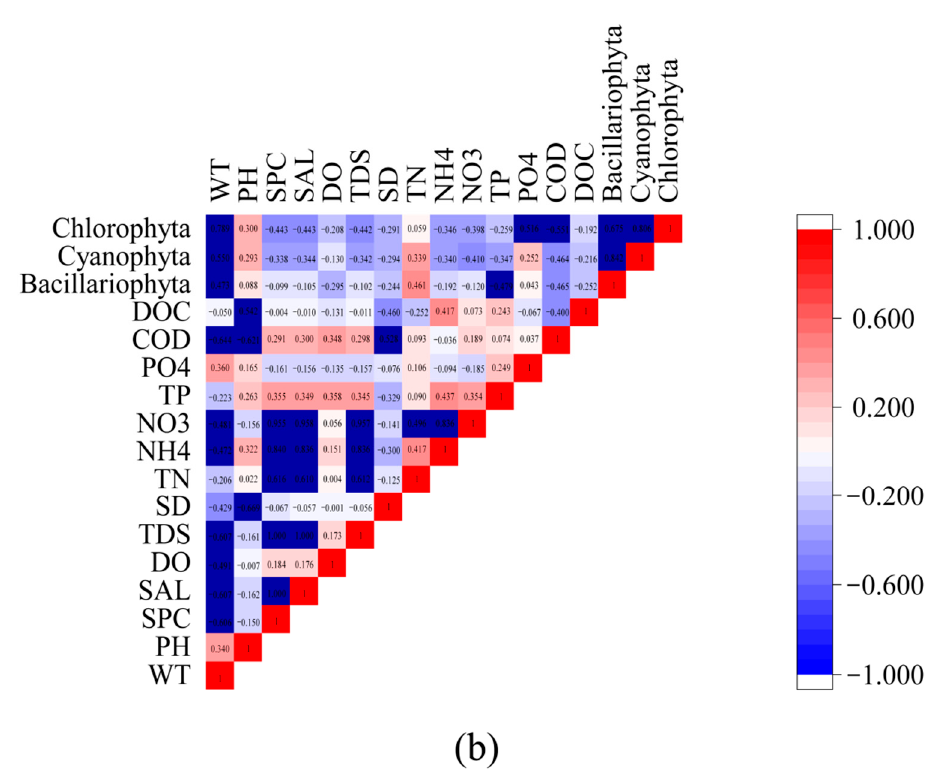
Figure 5. Correlation heat map of periphytic algae and environmental factors in summer ( a ) and winter ( b ).